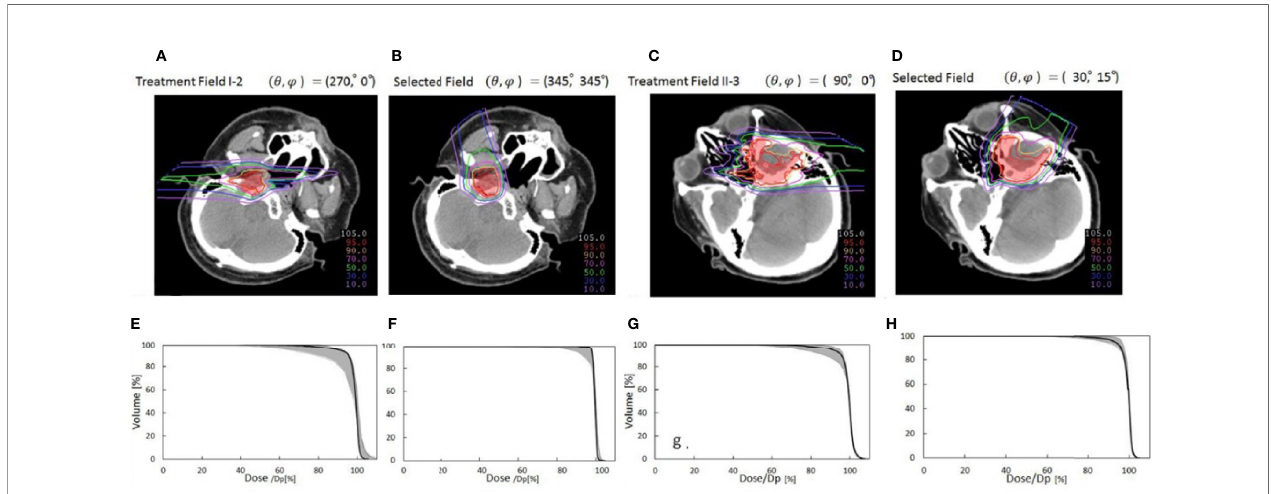
FIGURE 8 | Comparison of dose distributions between selected fi elds based on low tissue heterogeneities and treatment fi elds. Panels (A, C, E, G) represent dose distribution and the corresponding DVH in the CTV of the manually selected beam angles, and panels (B, D, F, H) indicate dose distribution and the corresponding DVH in the CTV of selected fi elds based on minimal tissue heterogeneities. The gantry and couch pitch angles are q and f , respectively. The CTVs are visible in red. The solid lines in panels (C , D , G , H) are DVHs for the dose distributions without setup and range errors. The shaded areas are the variation of the DVHs with range error ( ± 2%) and setup error ( ± 2 mm) (55) (Source: IOP Publishing. Used with